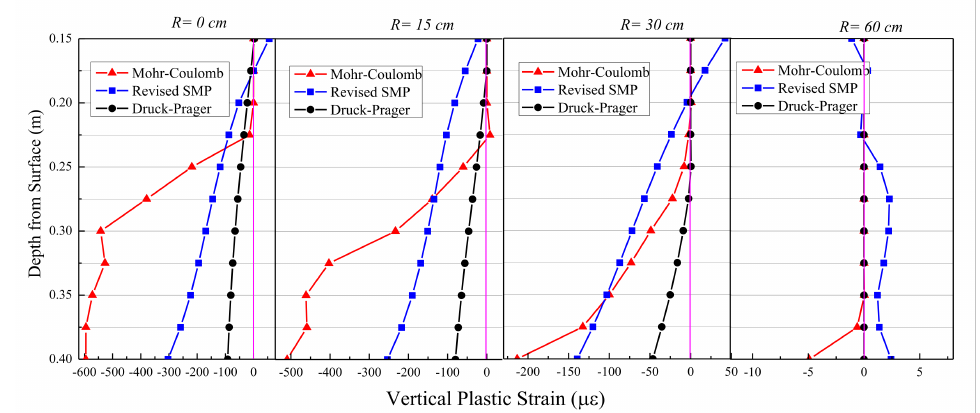
Figure 7. Vertical plastic strain of UGM layer using the three